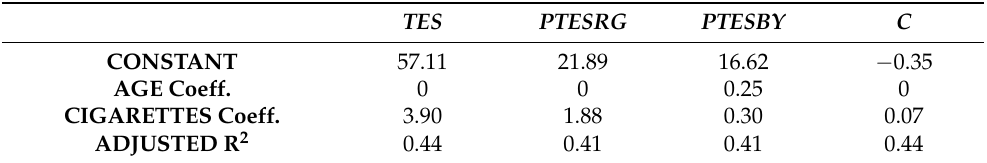
Table 3. Constant, variable coefficients, and adjusted coefficient of determination for a linear regres- sion model. Dependent variables: FM100h scores ( TES , PTESRG , PTESBY , and computed principal component C ); independent variables: age and number of smoked cigarettes. TES PTESRG PTESBY C CONSTANT AGE Coeff. CIGARETTES Coeff.